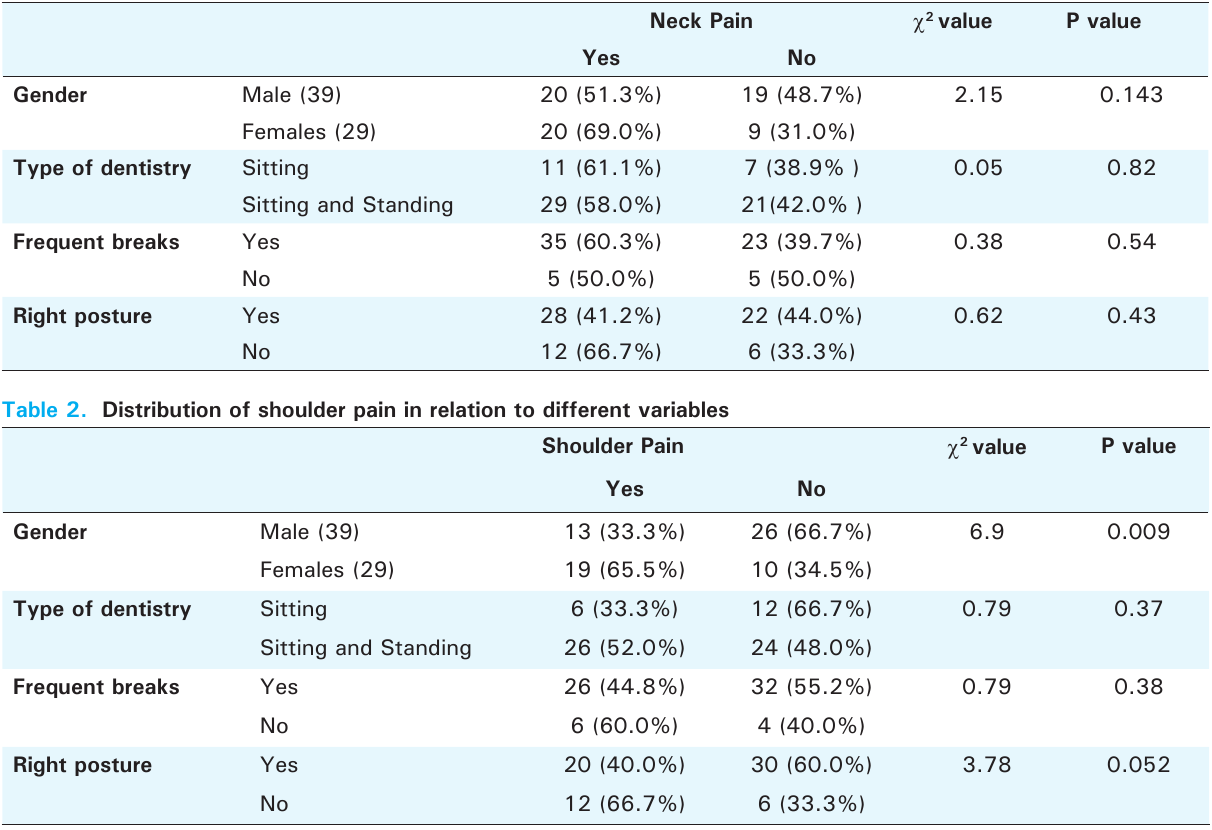
table 3. distribution of back pain in relation to different variables